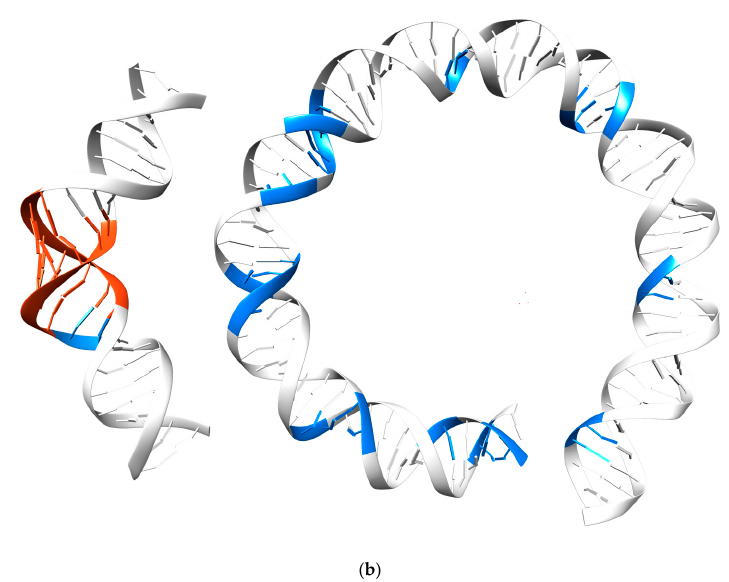
Figure 4. DNA bending in the regulatory complexes and in the nucleosome core particles (NCP). ( a ) Blue lines: the local helical bend of DNA in NCP structures of the PDB codes 5f99 [29] and 5cpk [30]; red lines: the bends for the regulatory complexes 4mzr [31], 1bl0 [32], 3tmm [33], 1zs4 [34], 4nnu [35], 1l3l [36], and 6cro [37]. The local helical axis bend was calculated by the Curves+ program [23] as the Ax-bend parameter. The x axis denotes the DNA residue numbering in 5f99. ( b ) The left duplex displays DNA from the structure of human TFIIB-related factor 2 and TATA box binding protein bound to U6#2 promoter DNA (PDB code 4roc [21]), where the DNA backbone acquires the A-DNA form (CANA letter AAA) at the bend. The duplex on the right depicts first 75 base pairs from DNA in NCP of the PDB code 5f99 [29]. Dinucleotides adopting the structure described by the CANA letter AAA ( BB2 ) are highlighted in red (blue) color.